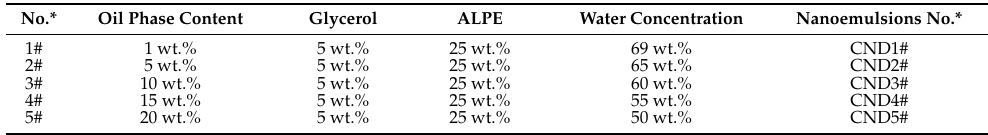
Table 4. The chemical composition of five stock solution and their nanoemulsions obtained after dilution.